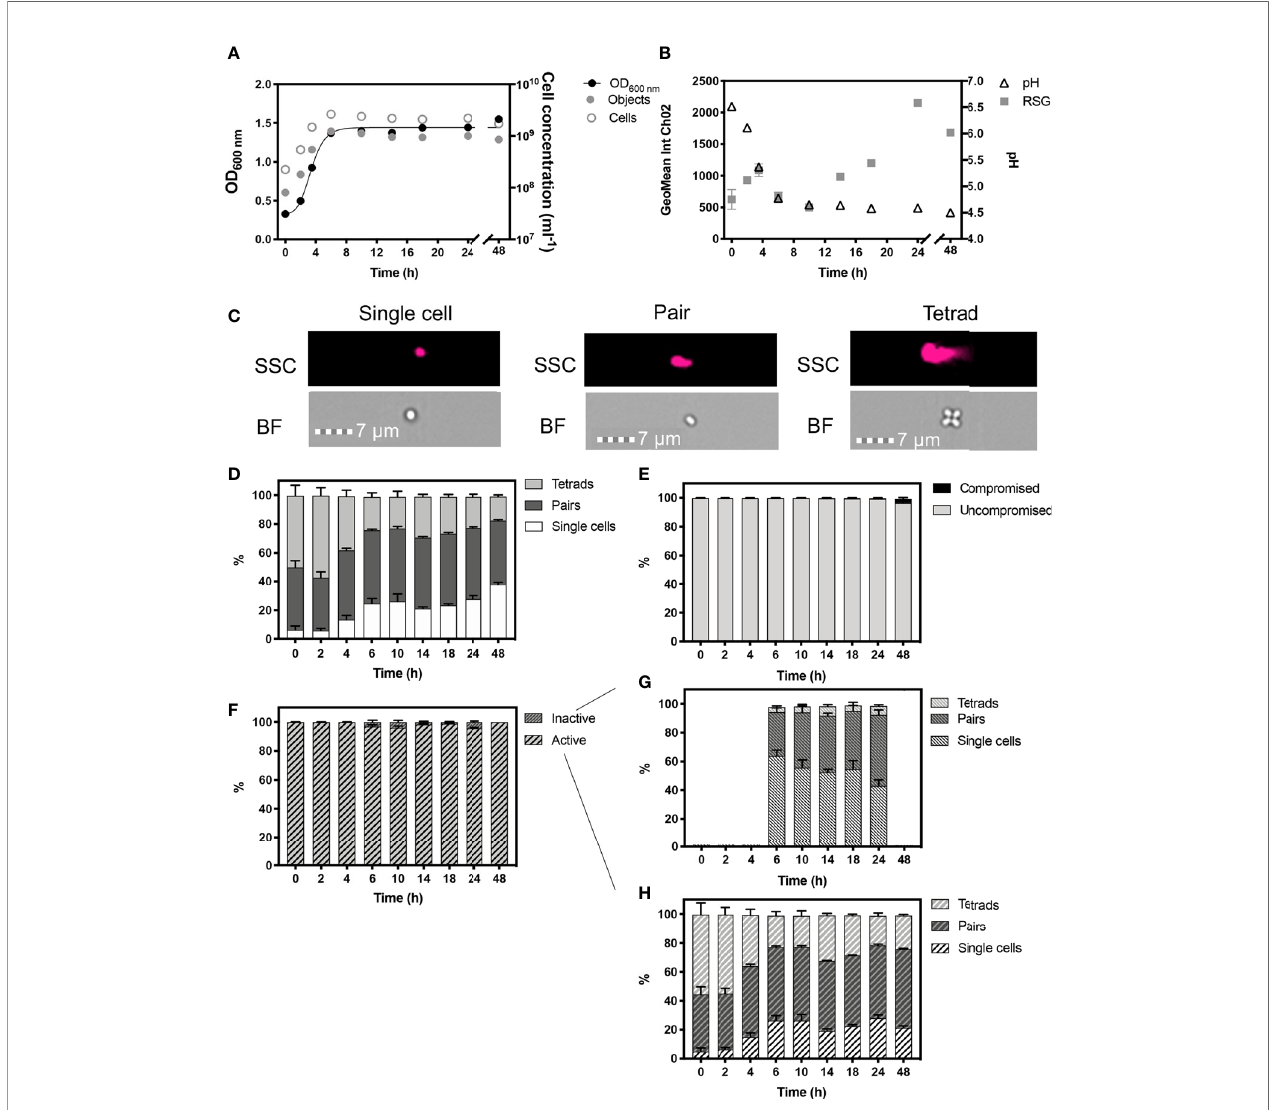
FIGURE 3 | Monitored phenotypes of Pediococcus acidilactici during 48 h growth. Measurements of optical density (OD 600 ) are plotted against IFC determined cell concentrations displayed as objects (ml -1 ) and cells (ml -1 ) (A) . Cells ml -1 was calculated via normalization of object concentration by cell type and used as a proxy for biomass. Geometric mean of redox sensor green (RSG), indicative of metabolism, was determined from Channel 2 (Ch02: 533/55 nm) intensity, and is plotted alongside media pH (B) . Cell phenotypes were characterised by cell length, determined by bright fi eld (BF) and side scatter (SSC) properties (C) . Proportions of cell length during growth are shown (D) . The proportion of cells with compromised and uncompromised cell membranes, was tracked using propidium iodine and determined by red fl uorescence intensity (Ch05: 702/85 nm), normalised for cell area (E) . Proportions of metabolically ‘ active ’ and ‘ inactive ’ cells are presented (F) . Cell lengths of ‘ inactive ’ (G) and ‘ active ’ (H) : cells within the uncompromised population are shown. n = 5 ; error bars represent standard error of the